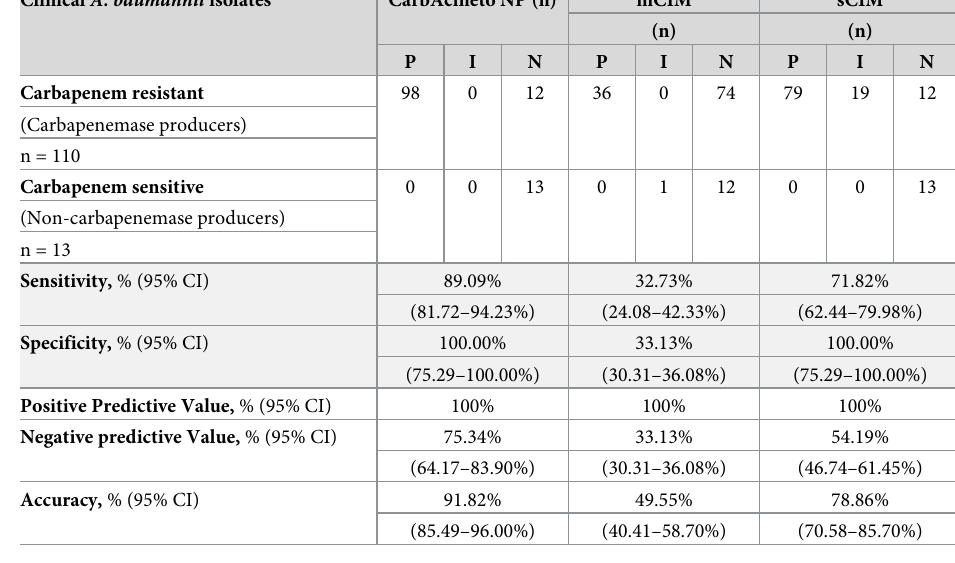
Table 1. Performance characteristics of phenotypic methods for detection of carbapenemase-producing A . baumannii . Clinical A . baumannii